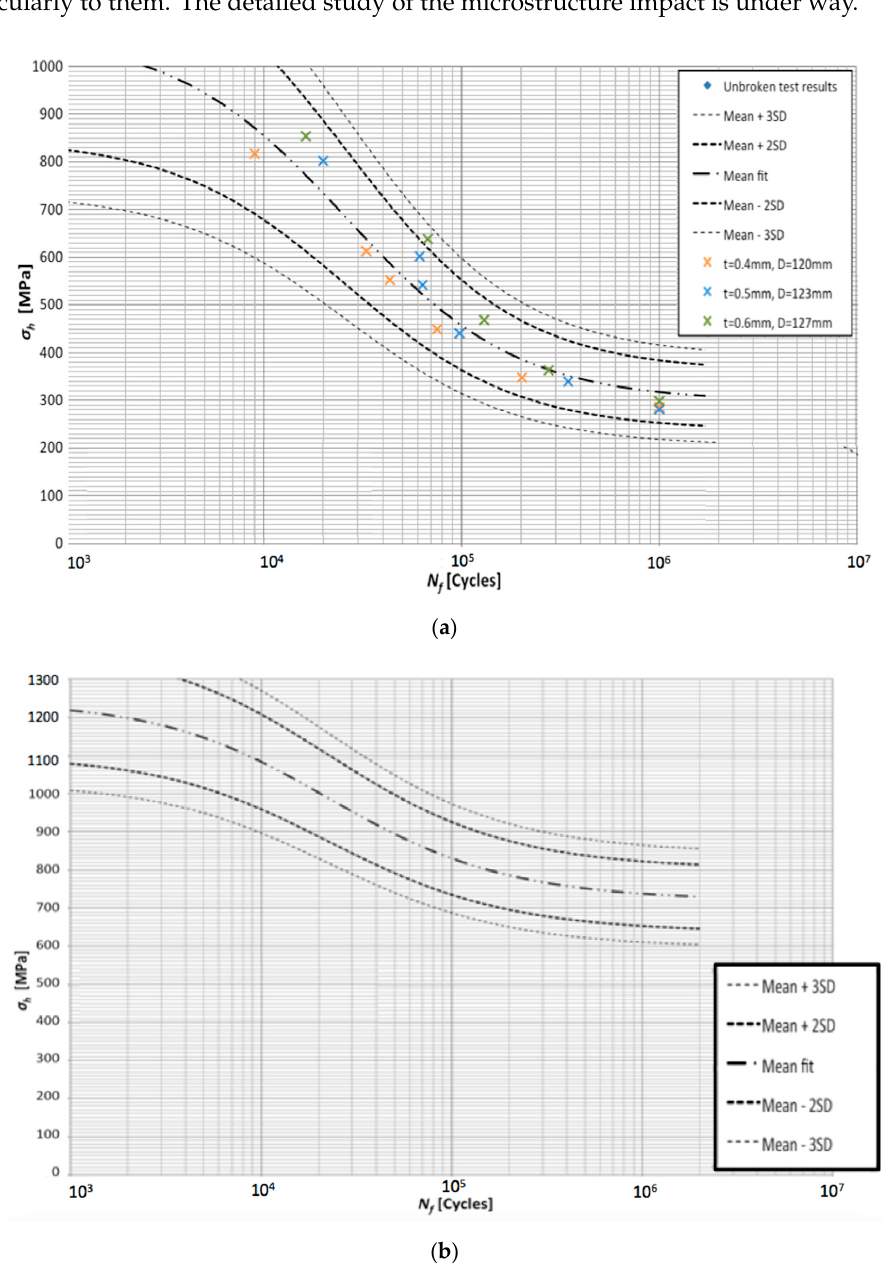
Figure 14. S-N logarithmic plot of hoop stress for fatigue strength of the tested sleeves, material 1.2709 with different porosity: ( a ) 0.4–0.6%; ( b ) 0.05–0.1%.